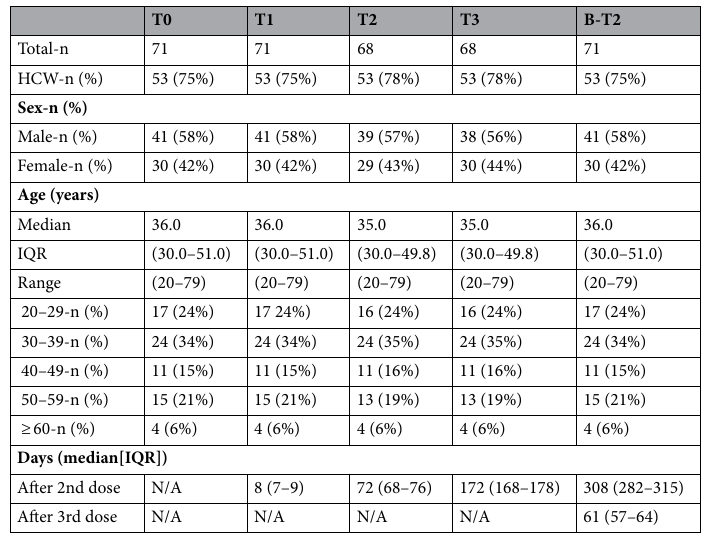
Table 1. Characteristics of the study participants. HCW health care worker, IQR interquartile